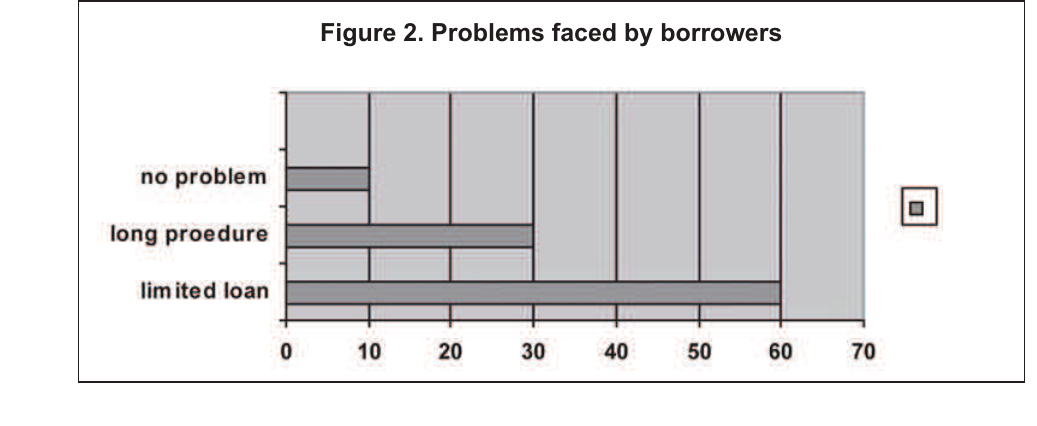
Figure 2. Problems faced by